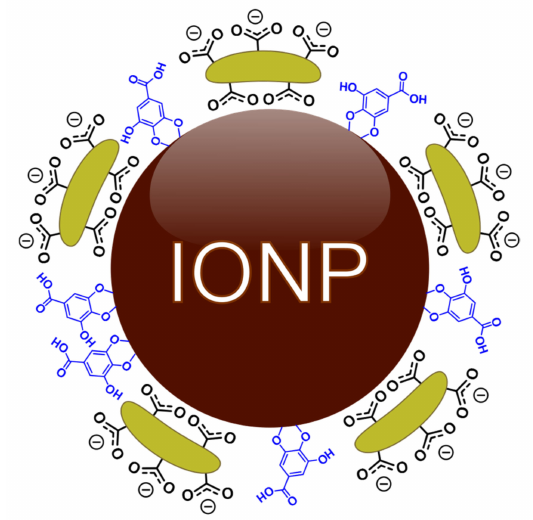
Figure 1. Ligand coverage of polyacrylic acid (green) and gallic acid (blue) coordinate to the surface of magnetite (Fe 3 O 4 ) to form the Fe 3 O 4 -GA/PAA